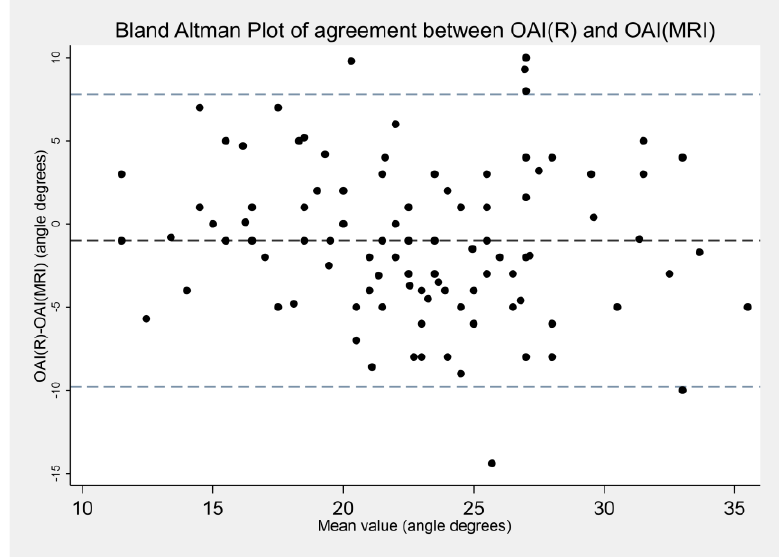
Figure 2. Bland–Altman plot, agreement of OAIR and OAIMRI measurements made by 4 raters in 1 round of rating. Mean difference −0.99, limits of agreement −9.8 to 7.8. OAI = osseous acetabular index.